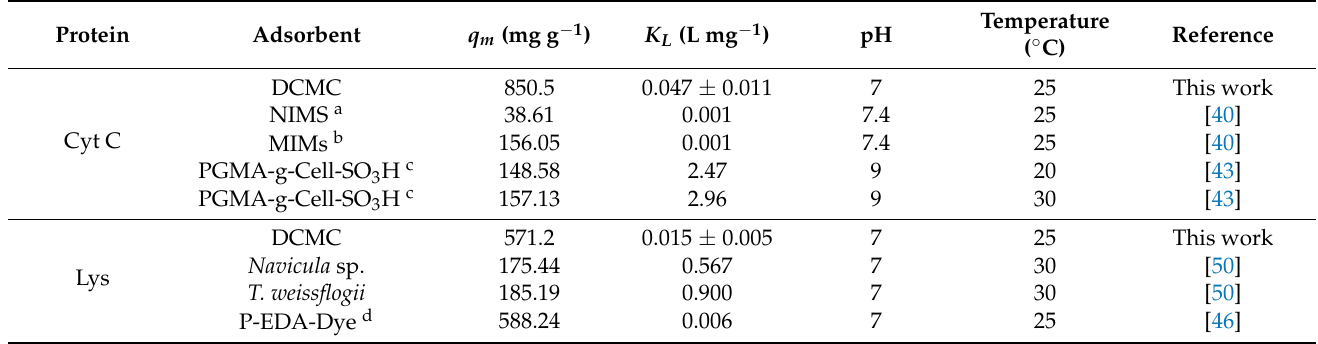
Table 4. Comparison of the maximum adsorption capacities and Langmuir equilibrium constants obtained for the adsorption of Cyt C and Lys onto various